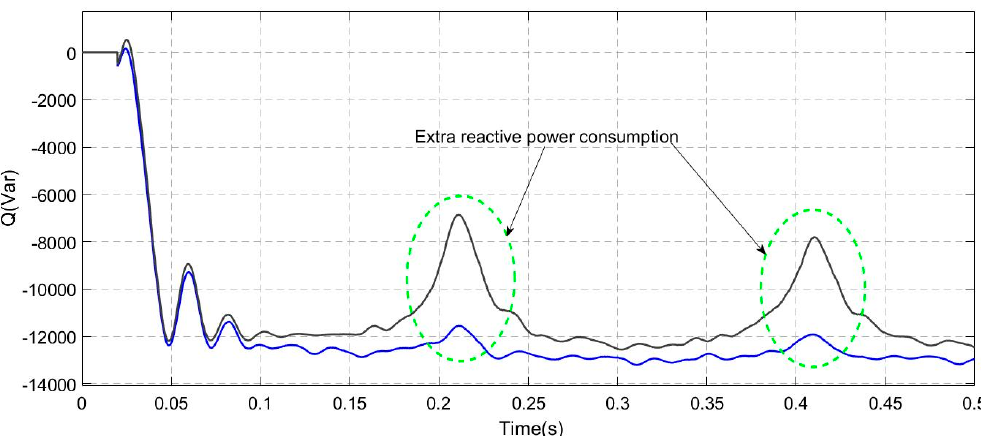
Figure 11. Waveforms of reactive power consumption in PV inverter under power factor control strategy and cloudy control mode.